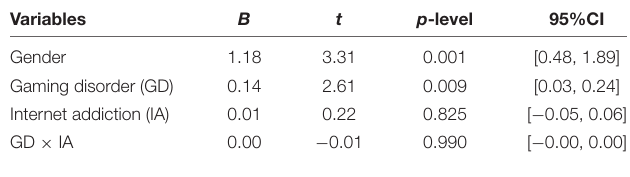
TABLE 3 | Hayes PROCESS macro results for internet gaming disorder predicting social bullying with internet addiction as moderator.